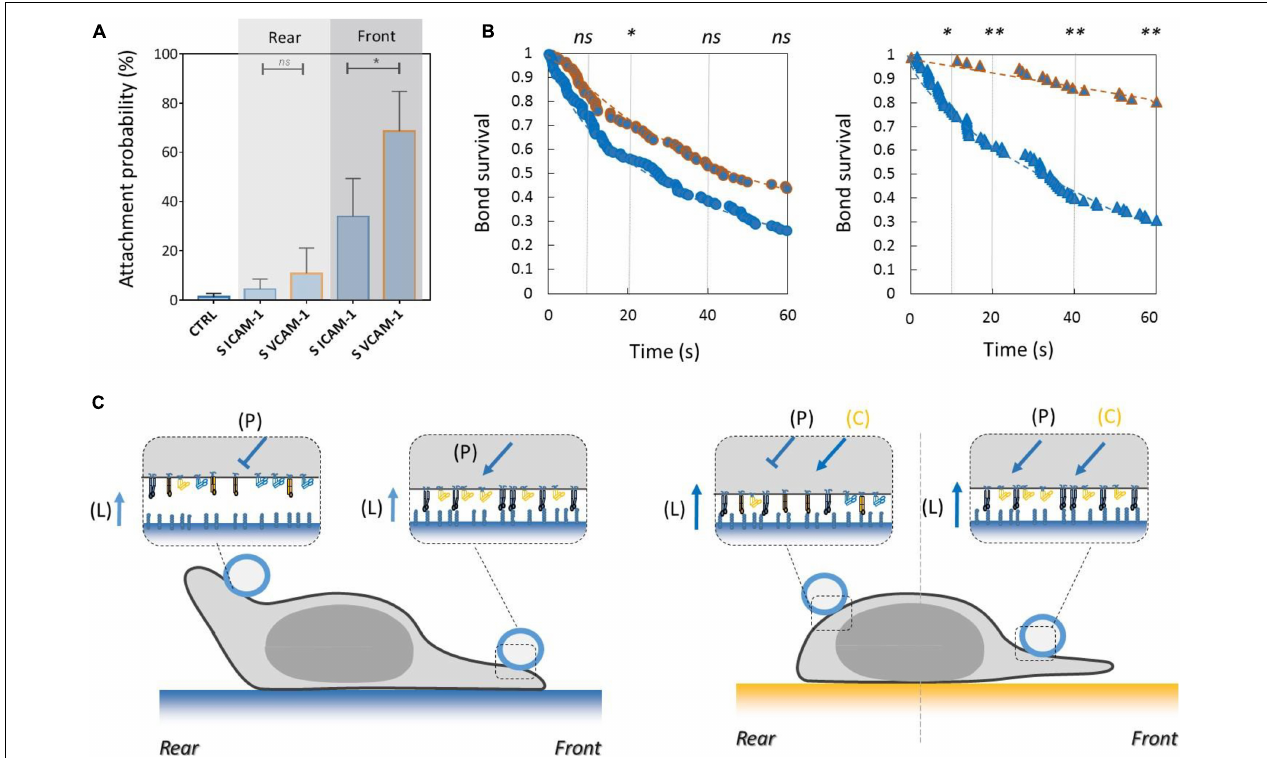
FIGURE 7 | Activating crosstalk of VLA-4 toward LFA-1 modulates cell surface adhesiveness on long distances across the cell. (A) Attachment probability of beads with ICAM-1 at 2400 molecules. µ m − 2 on the rear and front of cells crawling on substrates coated with ICAM-1 (S ICAM) or VCAM-1 (S VCAM) at 1200 molecules. µ m − 2 . CTRL corresponds to beads coated with irrelevant IgG. Number of independent experiments Nexp = 3. Number of events_per_experiment Ne > 40. (B) Survival versus time of bead/cell bonds formed on cell rear (circles) or on cell front (triangles) with cells crawling on substrates coated with ICAM-1 (marks circled in blue) and on VCAM-1 (marks circled in orange). Number of independent experiments Nexp = 4. Number of events_per_experiment Ne > 70. (C) Cartoon of cell with bead and substrates coated with ICAM-1 (top) and VCAM-1 (bottom). Orange arrows and T-lines indicate activation and inhibiting effects on VLA-4, and letters indicate their origin, i.e., the polarization machinery (P), ligand bonding (L), and crosstalk from LFA-1 (C). Error bars are standard deviations for independent experiments. ∗ P < 0.05 and ∗∗ P < 0.01, with respect to unpaired Student t -test. In B, statistical tests were performed at 10, 20, 40, and 60 s (dashed lines) and results indicated above the